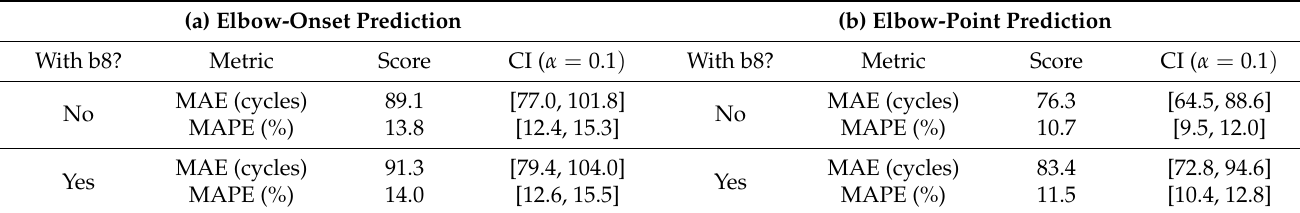
Table 5. Result of RVM regressor for elbow-onset ( a ) and elbow-point ( b ) when predictions are made from the first 50 cycles. The 90% confidence intervals (CI) were calculated via bootstrapping. The entry ‘With b8?’ refers to results computed with (‘Yes’) and without (‘No’) the inclusion of the artificially predicted IR data of batch 8. (a) Elbow-Onset Prediction (b) Elbow-Point Prediction With